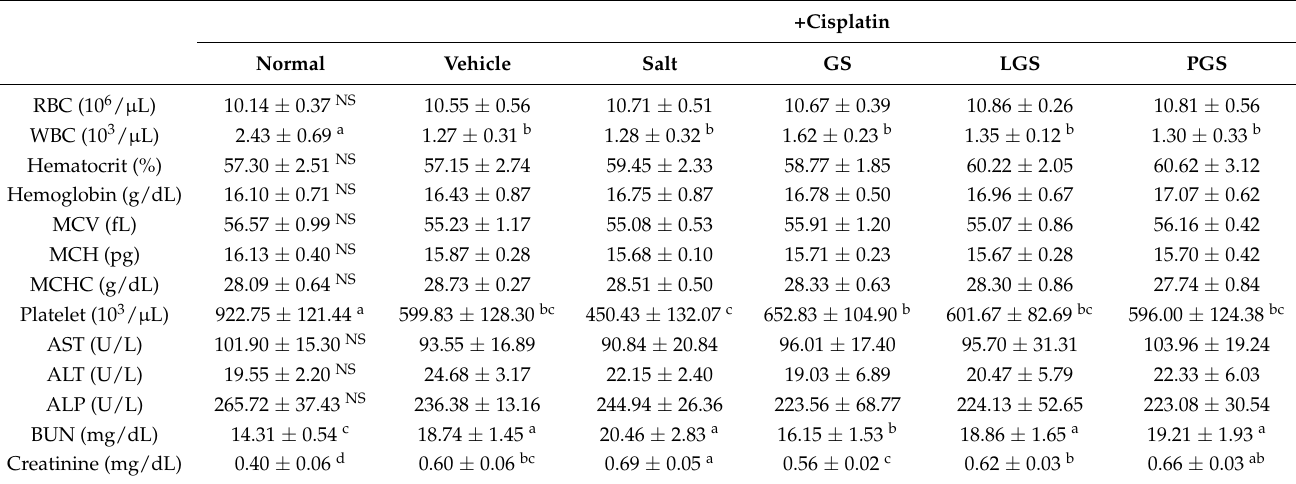
Table 1. Changes of hematological and biochemical profiles after orally administered GABA-enriched salt in cisplatin-induced